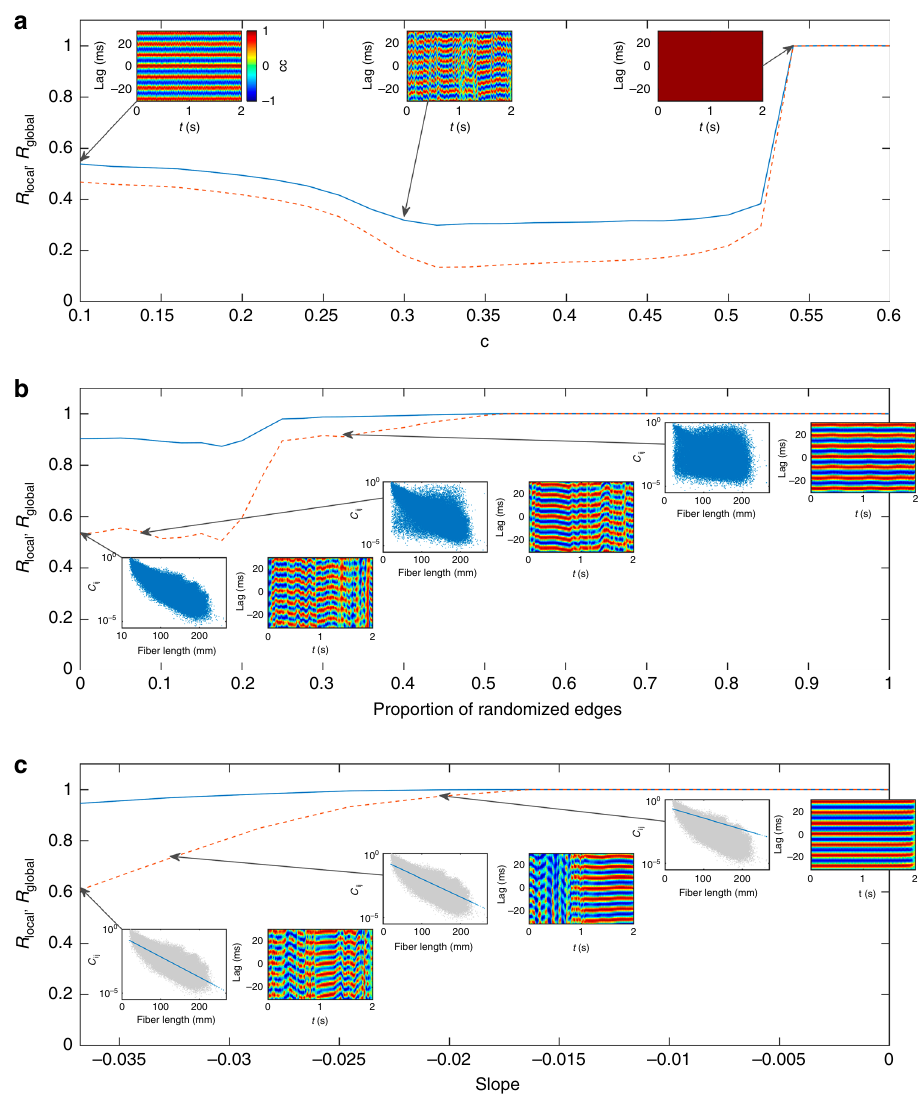
Fig. 10 Local and global synchrony for surrogate networks. a Local and global synchrony in fully randomized networks as a function of coupling strength c . Lines show synchronization order parameters R local (solid) and R global (dashed). Insets show the interhemispheric cross-correlations at representative values of c , denoted by the arrows. b Loss of waves with progressive structural network randomization, parameterized by the proportion of randomized edges. Insets show the (log-)weight-vs.- fi ber length relationships (blue point clouds) and the interhemispheric cross-correlations for the proportion of randomized edges denoted by the arrows. Lines are an average over an ensemble of ten random surrogates at each point. c Waves in synthetic networks with pure exponential weight – distance relationship, parameterized by the slope of the linear log 10 (weight)-vs.- fi ber length relationship. Insets show the (log-)weight-vs.- fi ber length relationships for the synthetic exponential networks (blue) and the original network (gray), and the interhemispheric cross- correlations for the slope values denoted by the arrows. Source data are provided as a Source Data fi le